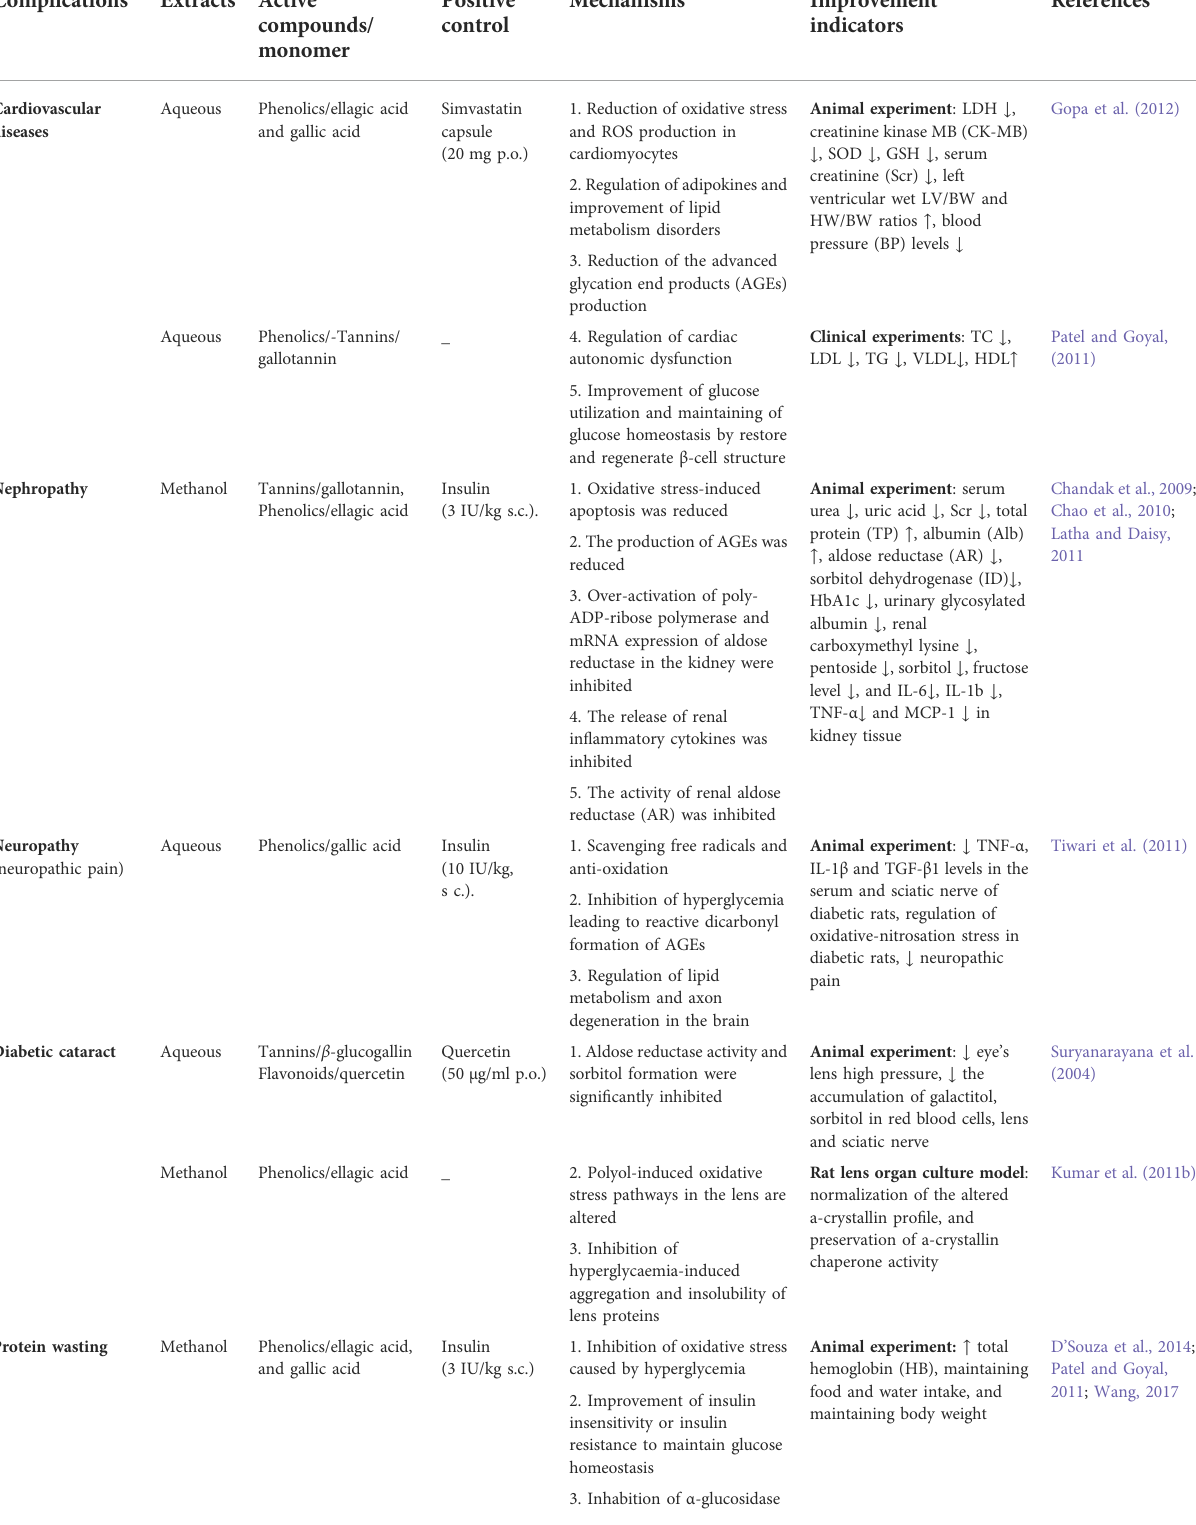
TABLE 4 The possible mechanisms underlying PF extracts against hyperlipidaemia and diabetic